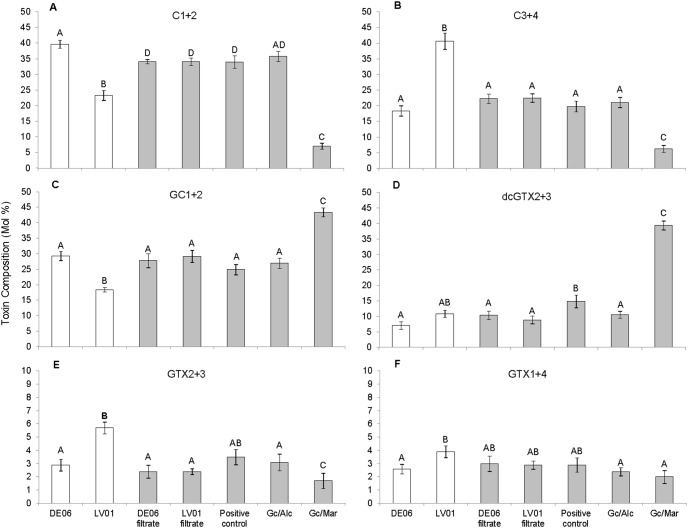
Toxin profiles (mol%) of each toxin group identified.The profiles of the identified toxin groups (C1+2, C3+4, GC1+2, dcGTX2+3, GTX2+3, and GTX1+4) from HPLC analysis on cultures at Day 25 (harvest), Error bars ± SE, n = 5. Superscripts indicate significant differences (p<0.05), means labelled with the same letter are not significantly different.